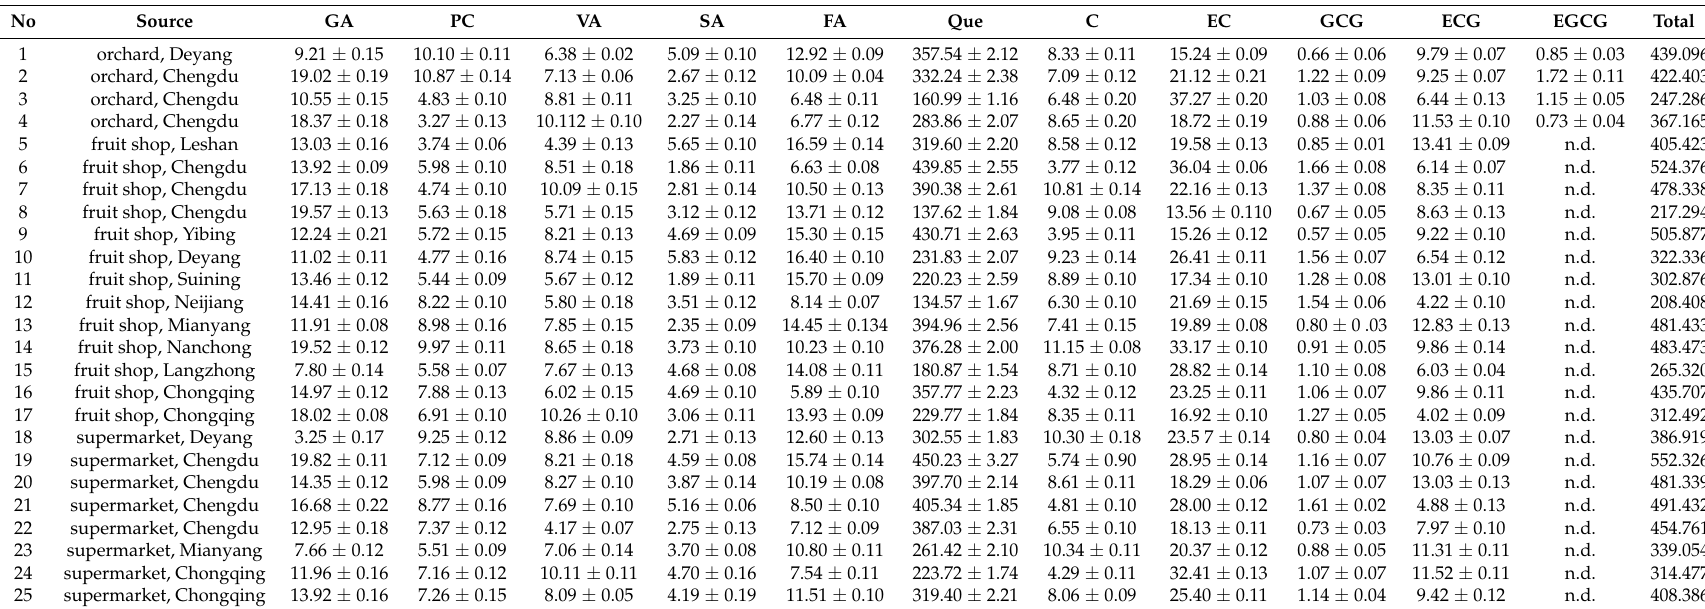
Table 4. The contents of 11 polyphenols in blueberry samples ( µ g/kg) (Mean ± SD, n =